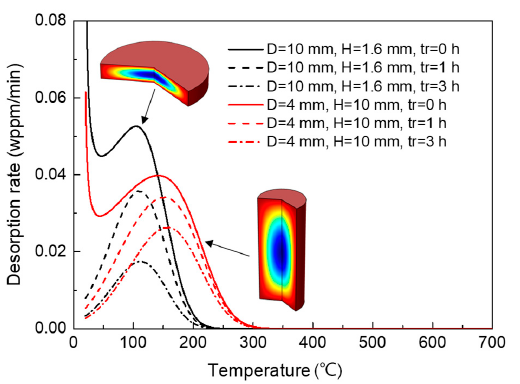
Figure 9. Desorption spectra for different specimen geometries ( D = 10 mm, H = 1.6 mm and D = 4 mm, H = 10 mm) and rest time. The specimen volume was held constant. Inset figures show the specimen geometries correspondingly.